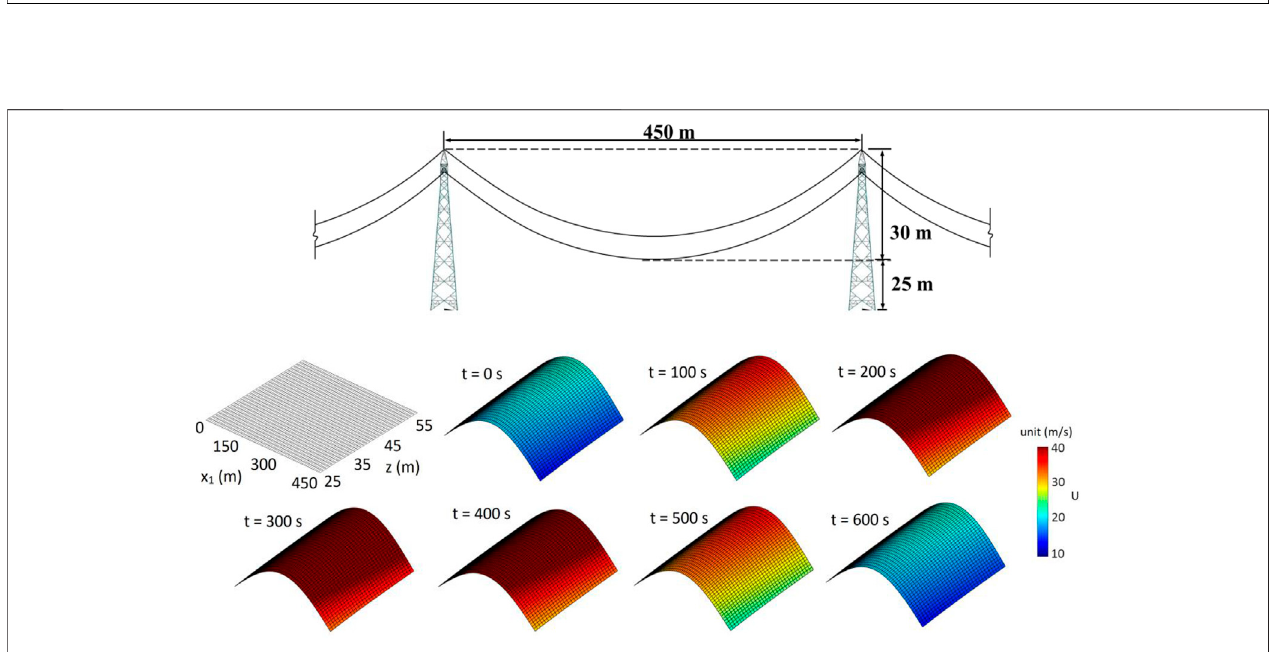
FIGURE 6 | De fi nition for the simulation of two-dimensional wind fi elds: (A) shows the exposure area (not to scale), and (B) shows the mean wind pro fi le in time and space.